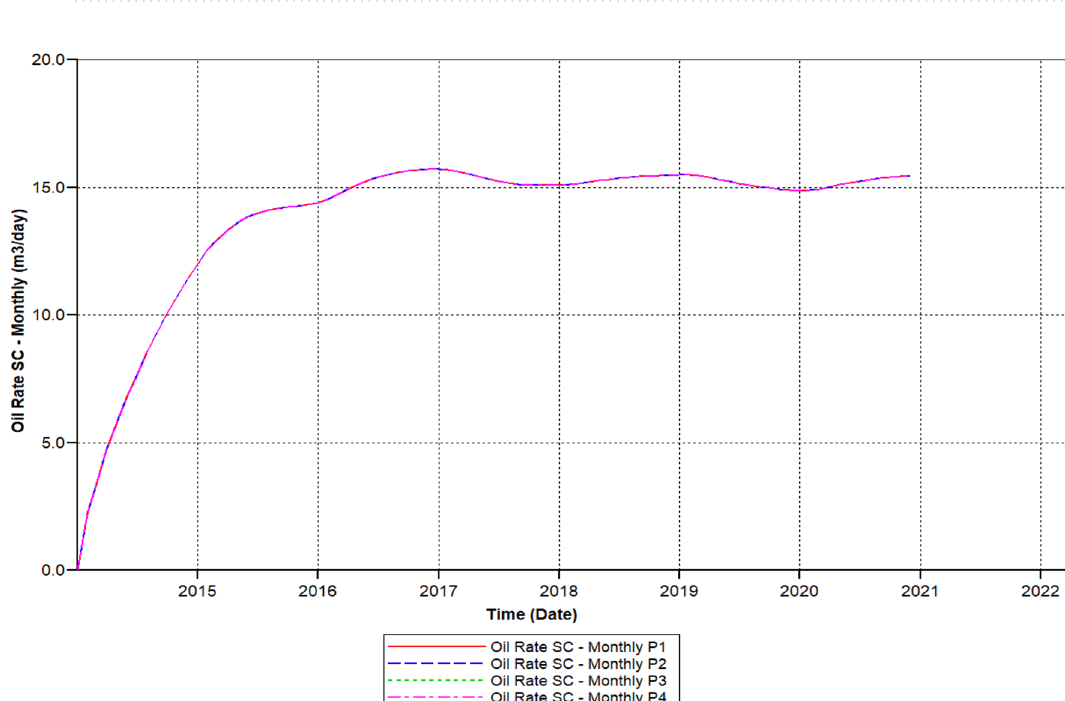
Figure 16. Shows the oil ratio afterwards the cross-linked gel treatment graph CMG STARS 2017.10 URL: https:// www. cmgl.